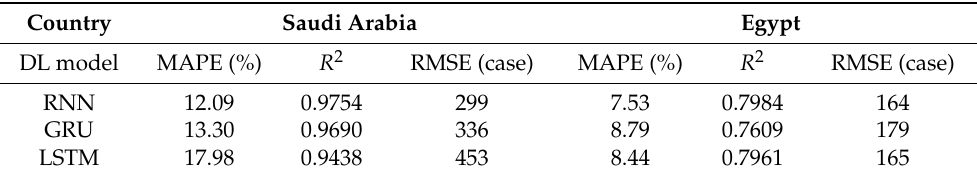
Table 4. Performance metrics of the RNN, GRU, and LSTM DL algorithms during the testing period (Saudi Arabia and Egypt).